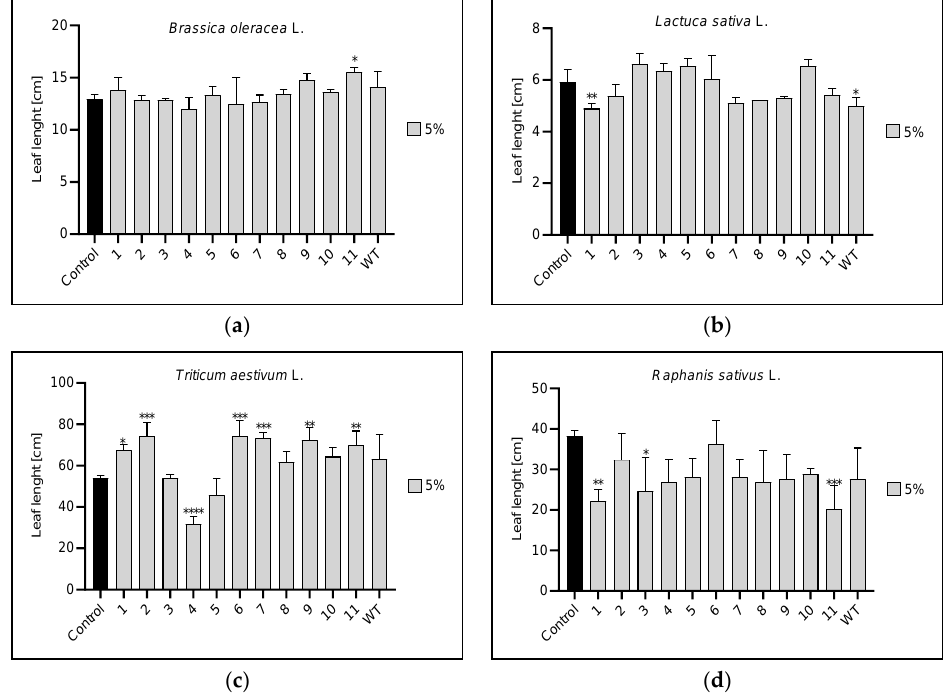
Figure 9 . Leaf length of broccoli ( a ), lettuce ( b ), wheat ( c ), and radish ( d ) sprouts treated with 5% concentration for all algae clones tested (1-11, WT) and control (Control). Values represent mean ± SD, n = 10 plants, * p < 0.1, ** p < 0.01, *** p < 0.001, **** p < 0.0001 compared to control (ANOVA and Dunnett ’ s a posteriori test). The leaf length of broccoli sprouts did not change under the influence of a concentra- tion of 10% (Figure 10a, Table 2). In the case of lettuce sprouts, clone 9 caused a reduction in the length of sprout leaves (Figure 10b, Table 2). The length of wheat leaves was re- duced under the influence of two strains (clones 4 and 6); meanwhile, clones 2 and 8 caused an increase in the length of wheat germ leaves (Figure 10c, Table 2). The concen- tration of 10% for all algae clones caused a significant reduction in the length of the leaves of radish sprouts (at the level of p < 0.0001) (Figure 10d, Table 2). ( a ) ( d ) Figure 10. Leaf length of broccoli ( a ), lettuce ( b ), wheat ( c ), and radish ( d ) sprouts treated with 10% concentration for all algae clones tested (1-11, WT) and control (Control). Values represent mean ± SD, n = 10 plants, * p < 0.1, ** p < 0.01, **** p < 0.0001 compared to control (ANOVA and Dunnett ’ s a posteriori test).